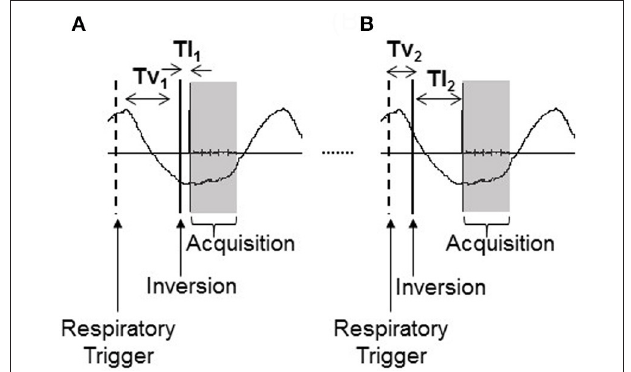
FIGURE 2 | Modified respiratory triggered inversion recovery sequence shown for (A) short (TI 1 ) and (B) long (TI 2 ) inversion time. By altering the variable delay, Tv, each image acquisition is collected at a constant time (Tv + TI) following the respiratory trigger. First arrow indicates the respiratory trigger (“Respiratory Trigger”), second the inversion pulse (“Inversion”), and the shaded block indicates the image acquisition readout